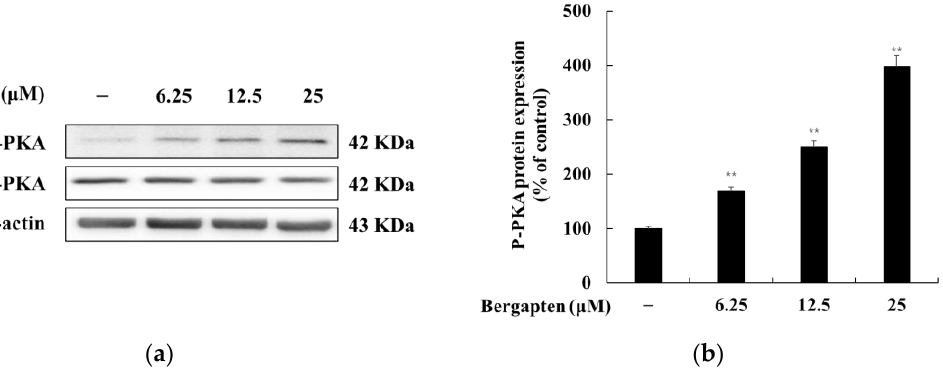
Figure 8. Effects of bergapten on the phosphorylation level of PKA in B16F10 melanoma cells. The cells were treated with bergapten (6.25, 12.5, and 25 μM) for 20 h. ( a ) Western blotting results and protein expression of ( b ) P-PKA/T-PKA. β -actin was used as a loading control. The results are presented as the mean ± SD of three independent measurements using Image J. ** p < 0.01 vs. the untreated group.